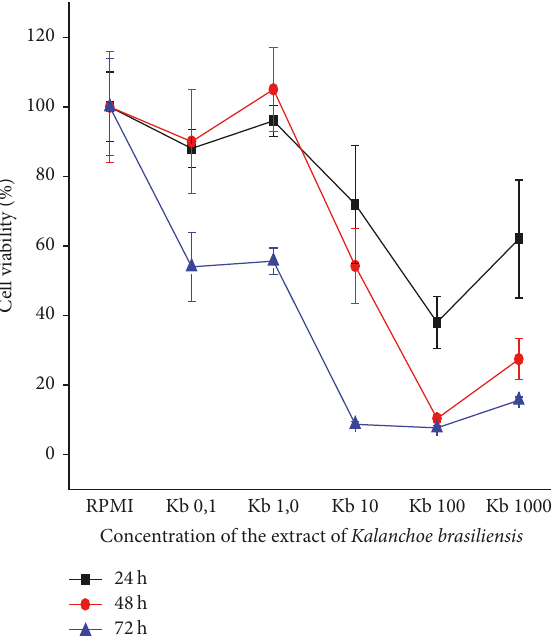
Figure 4: Viability of renal carcinoma cells (786-0) at periods of 24- , 48-, and 72-hour exposure to concentrations of 1–10 4 𝜇 L/mL of K. brasiliensis extract by the MTT